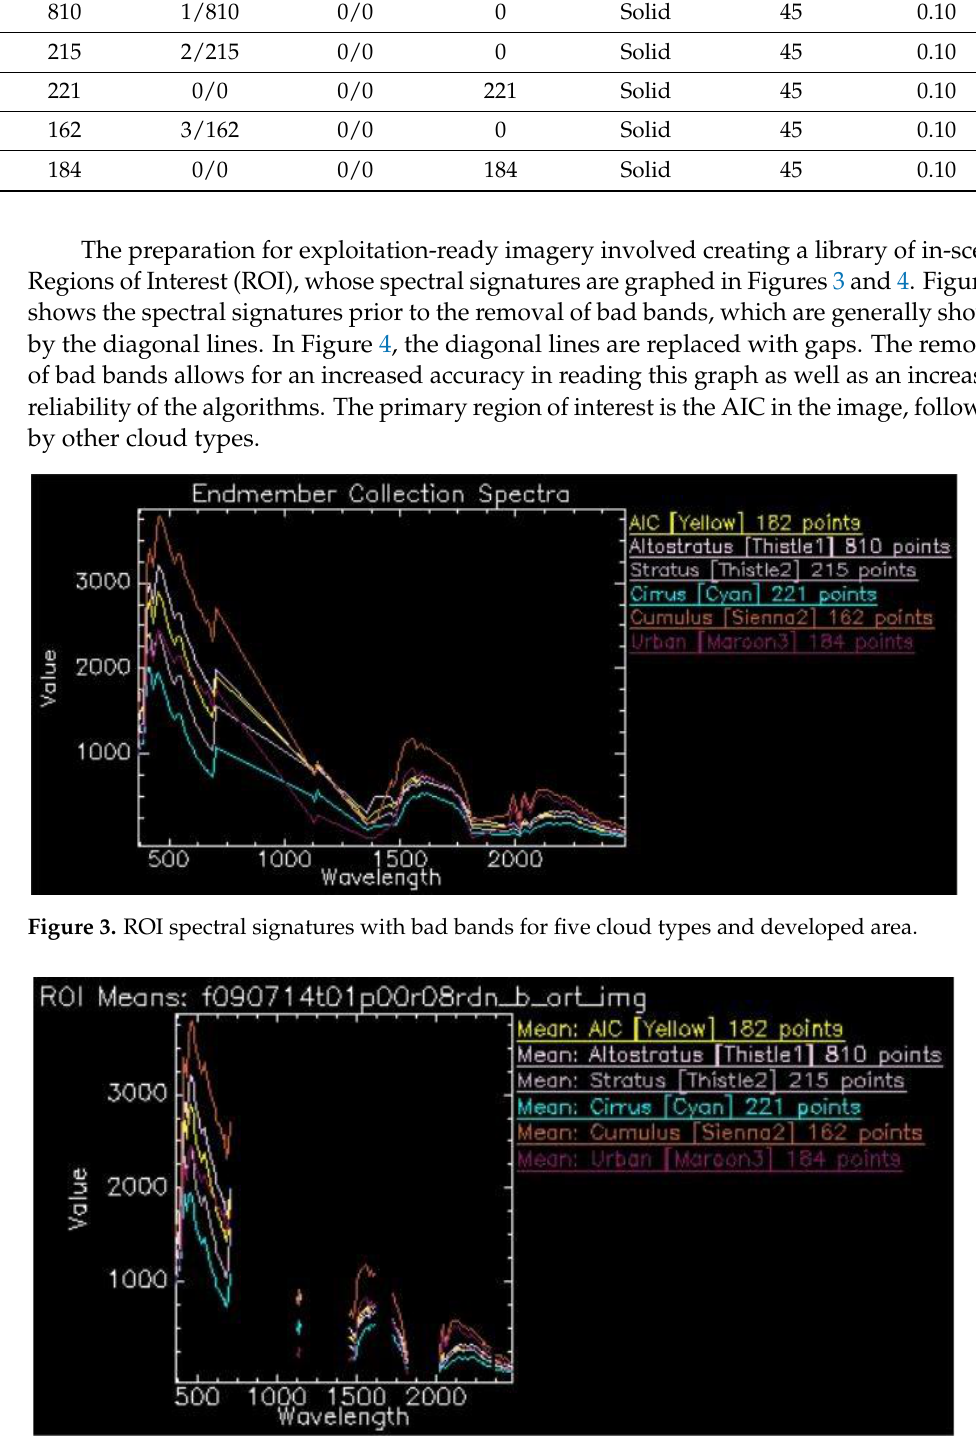
Figure 4. ROI spectral signatures without bad bands for five cloud types and developed area.